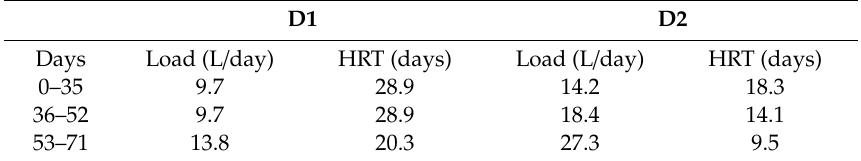
Table 1. Description of the di ff erent loading rates and hydraulic retention times (HRT) for D1 and D2.